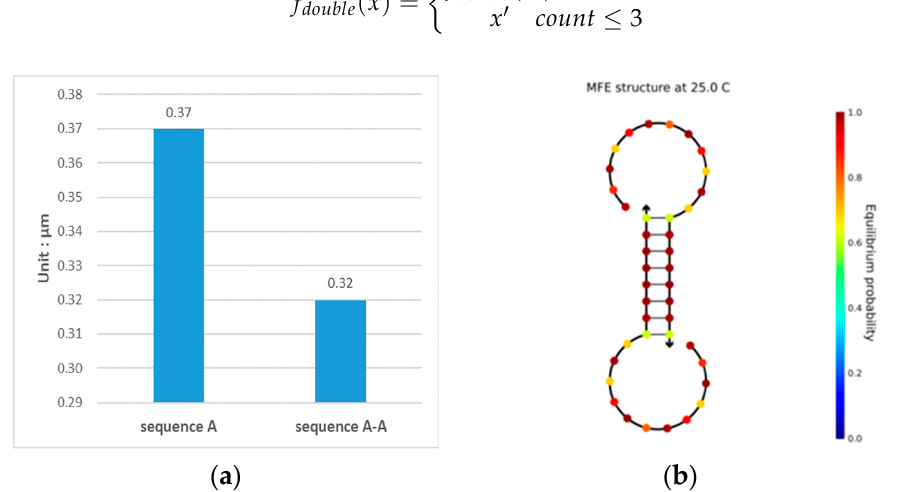
Figure 2. Analysis results of sequence TCTGTACTGCTGACTCGAGT. ( a ) Sequence species and concentration after the sequence enters the solution; sequences A and A-A obtained by the comple- mentary pairing reaction after the analyzed sequence enters the solution; ( b ) the secondary structure diagram of sequence A-A.